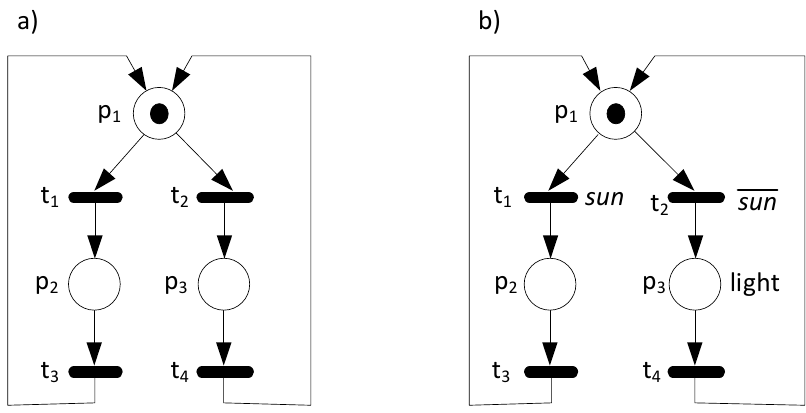
Figure 1. A Petri-net-based system with conflict ( a ), and its possible resolution ( b